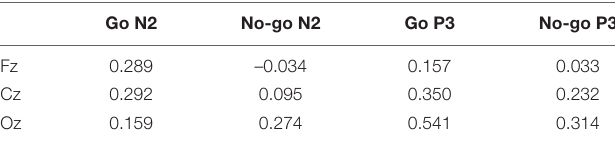
TABLE 3 | Correlation between RT and ERP